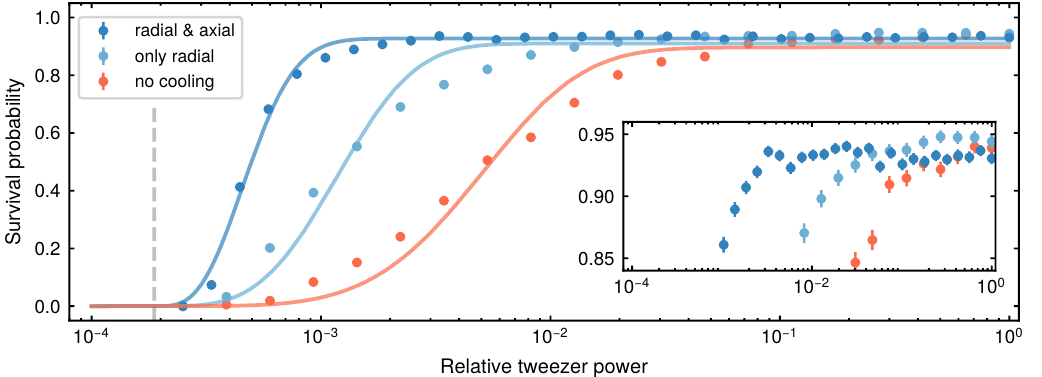
Figure 3: Atomic survival probability when adiabatically decreasing the trap depth. The data is the average of 64 tweezers with full Raman sideband cooling (dark blue), cooling only on the radial axis (light blue) and no additional cooling (orange). The solid lines are theory fits of a Boltzmann distribution, taking into account gravity. Due to gravity, for relative powers below 2 · 10 − 4 (dashed grey line) the atoms are not confined in z anymore. The inset shows a zoom in the y axis. We attribute the mismatch of the tweezer averaged data and the fit for higher powers to tweezer-to- tweezer